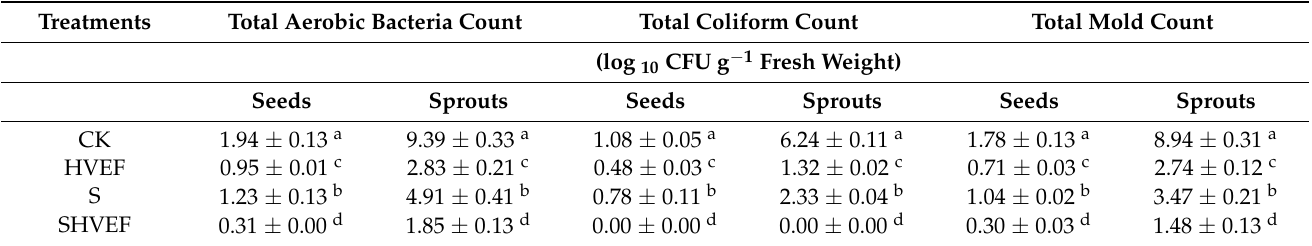
Table 4. Effects of soaking (S), high-voltage electric field (HVEF), and soaking plus high-voltage electyric field (SHVEF) treatments on the microbial loads of adzuki bean seeds and 6-day-old adzuki bean